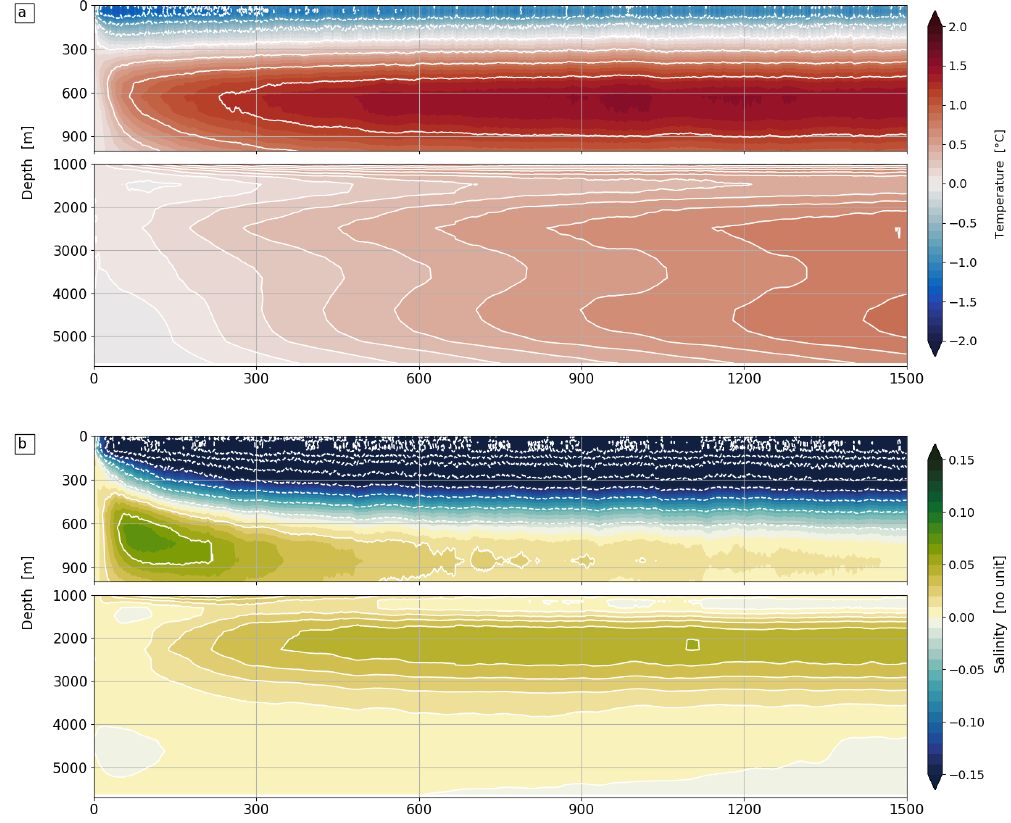
Figure 14. FOCI-piCtl area-weighted global anomalies with respect to the initial state for (a) potential temperature (in ◦ C) and (b) salinity as a depth–time graph. White contour lines indicate 0.4 ◦ C temperature and 0.04 salinity intervals above 1000m, 0.1 ◦ C for temperature and 0.01 for salinity below 1000m, respectively. Also note the different vertical scale below